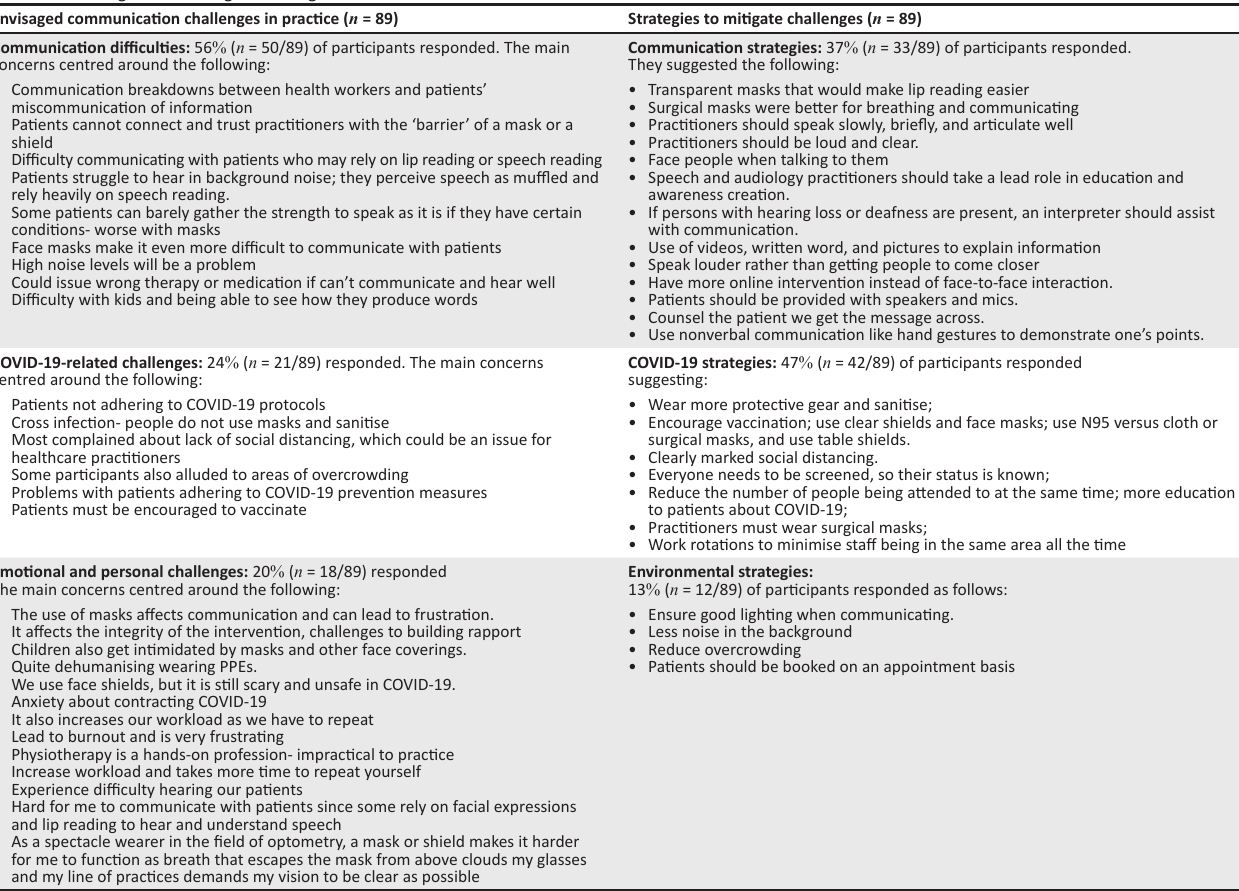
TABLE 3: Challenges and strategies to mitigate